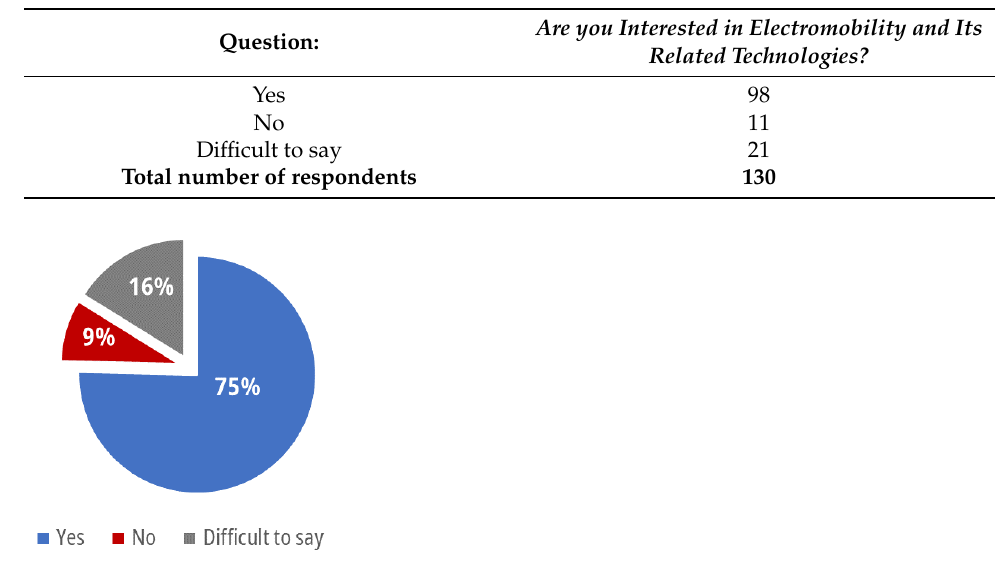
Table A2. Detailed responses to question (1).